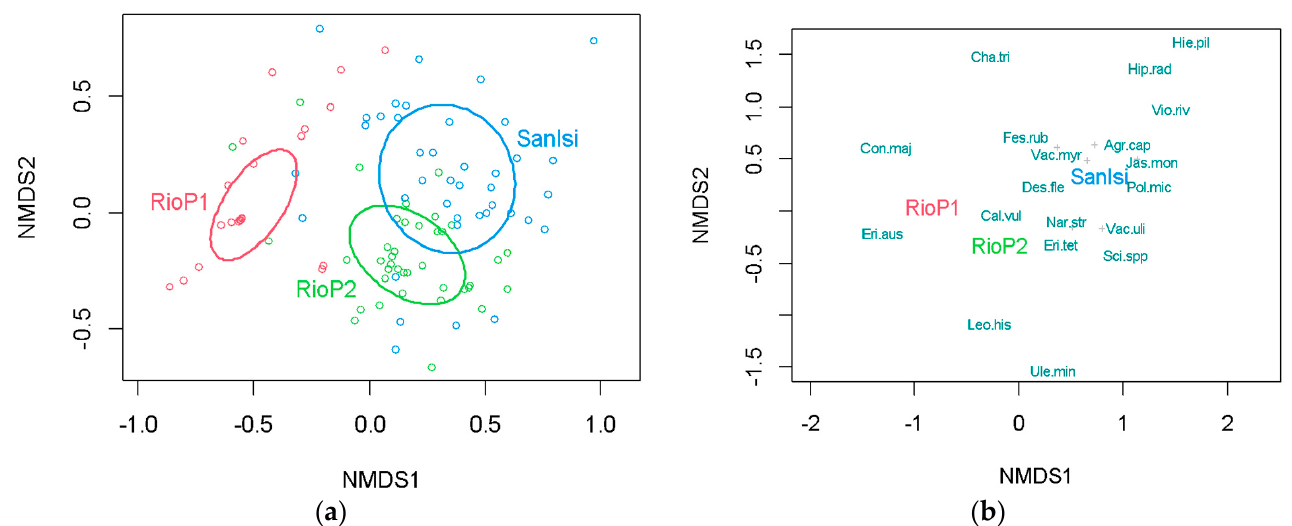
Figure 1. NMDS ordination for the first two axes of vegetation compositional differences between the three heathlands before any treatment application in the Cantabrian Mountain range, illustrating: ( a ) Ordination biplot with deviational ellipses for the three sites; ( b ) species biplot where only species with greater cover are shown. Less important species are represented as grey crosses. Spe-